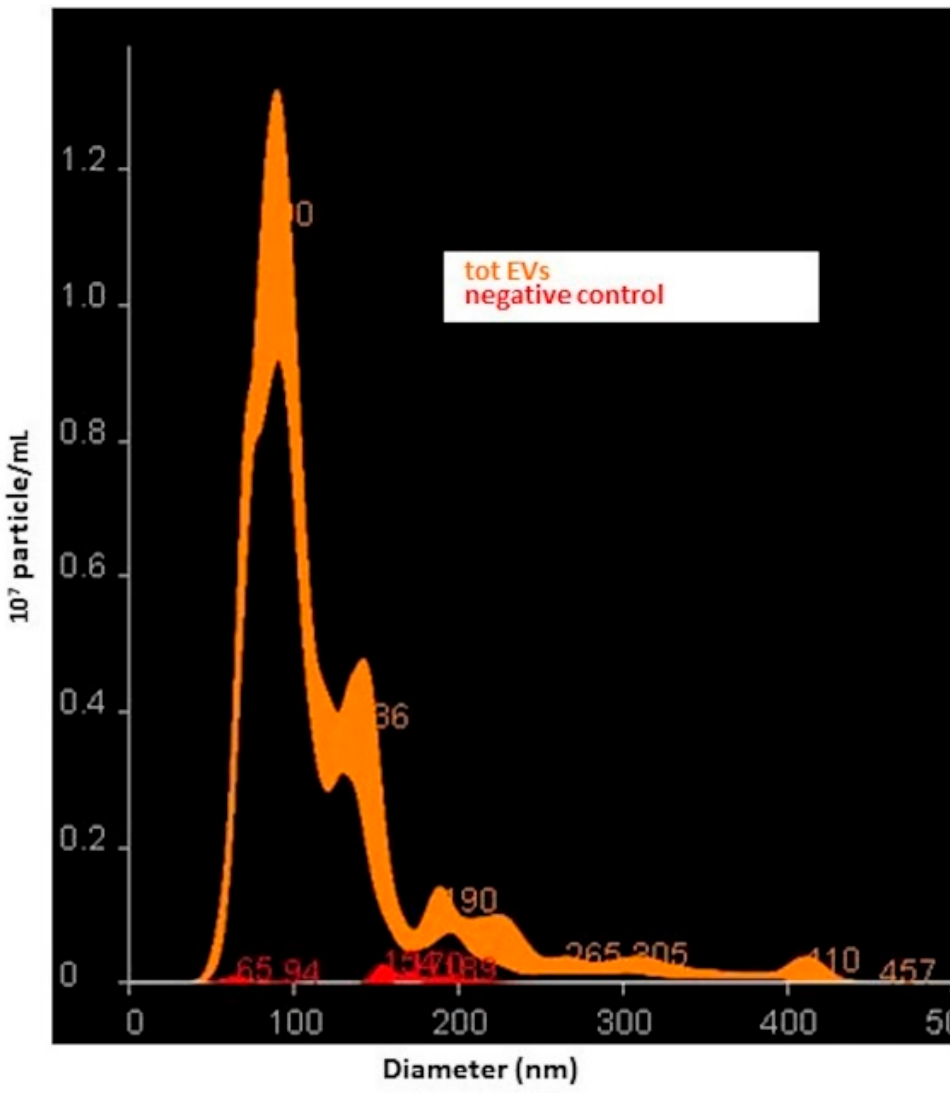
Figure 1. Nanoparticle tracking analysis (NTA). Representative outcomes of total small extracellular vesicles (EVs) suspension and its negative control are reported.